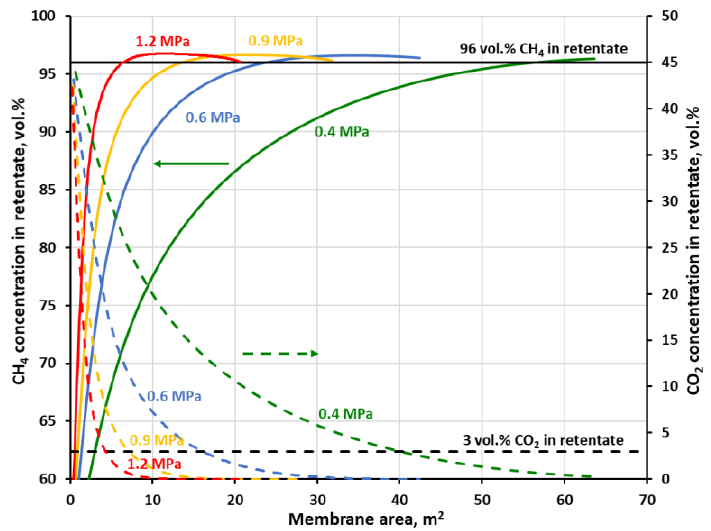
Figure 8. CH 4 (solid lines) and CO 2 (dashed lines) concentration in retentate against membrane area and feed gas pressure for a one-stage biogas upgrading system with the polysulfone (PRISM PA1020) membrane.